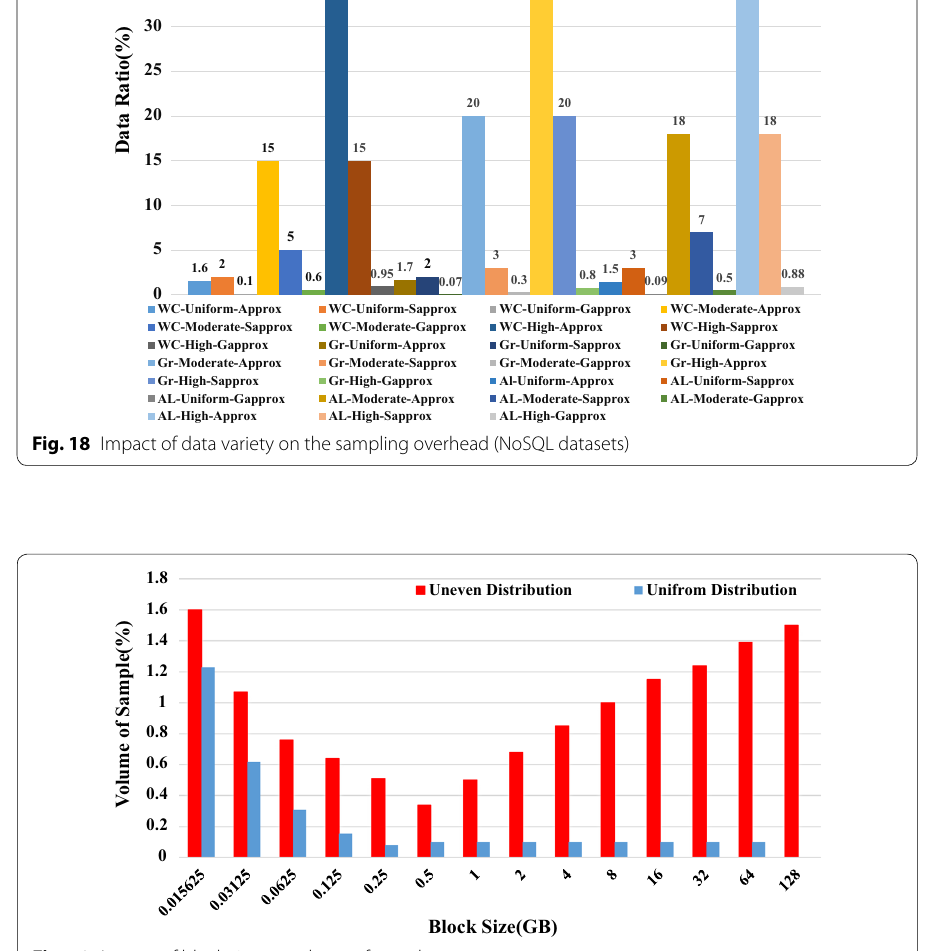
Fig. 19 Impact of block size on volume of